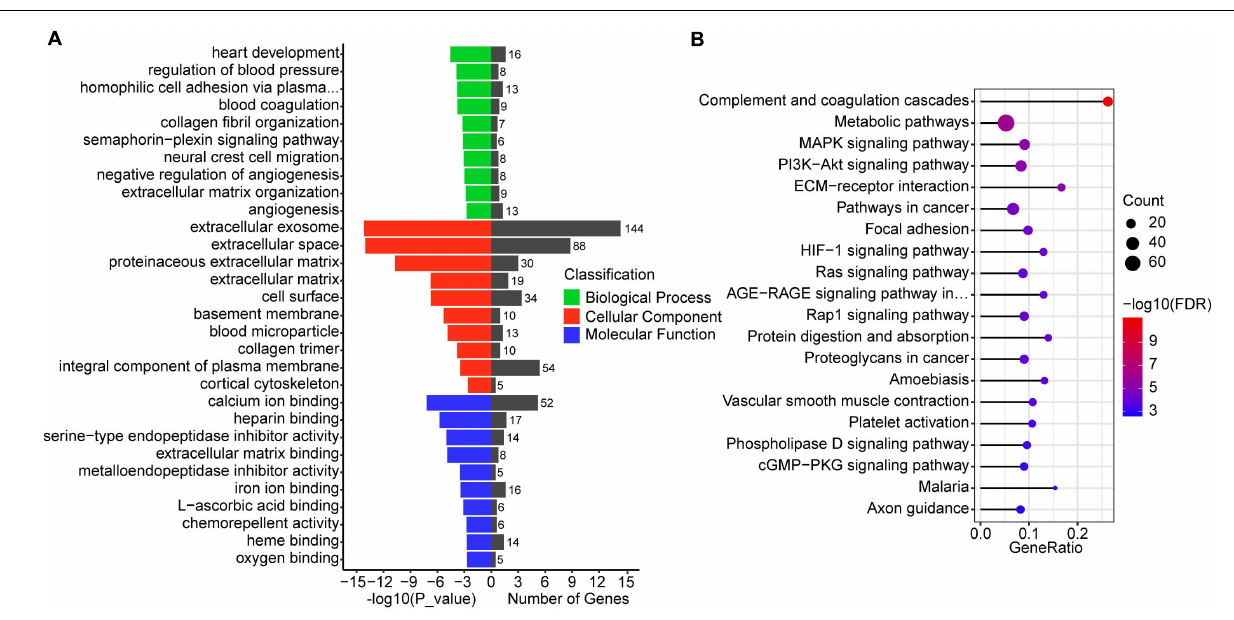
FIGURE 4 | GO and KEGG enrichment analysis of differentially co-expressed genes. (A) GO enrichment analysis of differentially co-expressed genes, the terms include biological process, cellular component, and molecular function. (B) Top 20 KEGG pathways of differentially co-expressed genes. The size of the circle represents the number of genes enriched in the pathway and red represents more significant